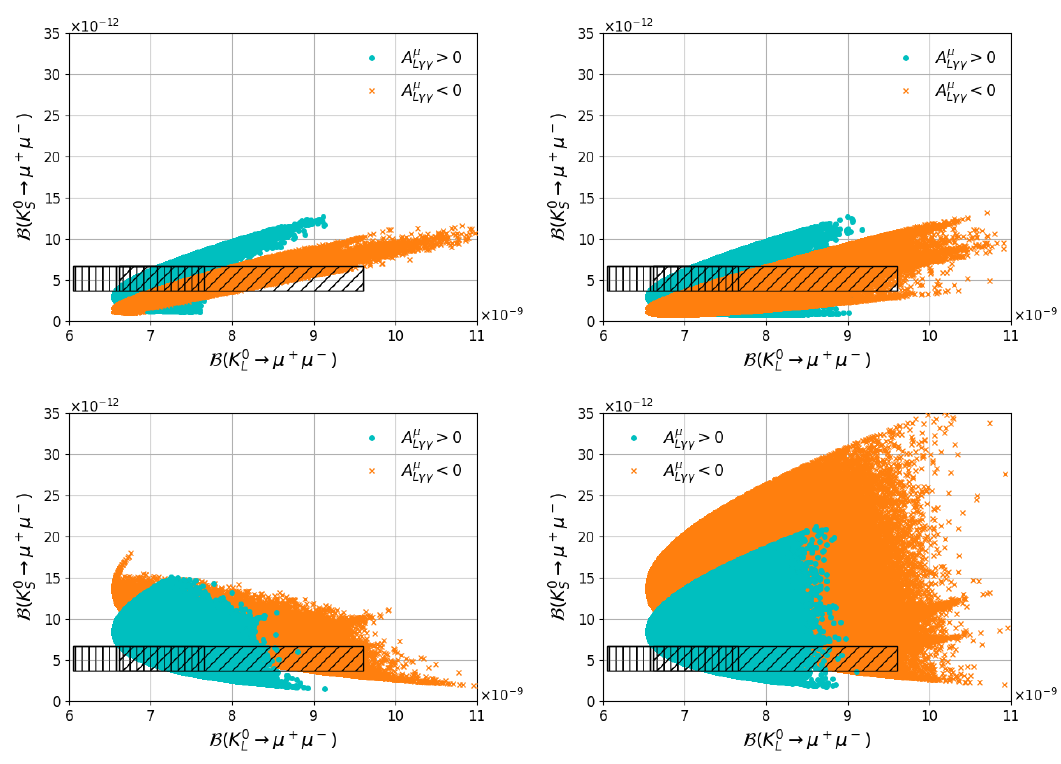
(cid:0) (cid:1) ! (cid:22) + (cid:22) (cid:0) ) for (cid:14) LL 6 = 0 and ( M 3 (cid:1) (cid:22) ) > 0 (upper L d 12 (cid:0) (cid:1) (cid:14) RR 6 = 0 and ( M 3 (cid:1) (cid:22) ) > 0 (lower left), and d 12 > 0 and the orange L(cid:13)(cid:13) > 0 L(cid:13)(cid:13) < L(cid:13)(cid:13)